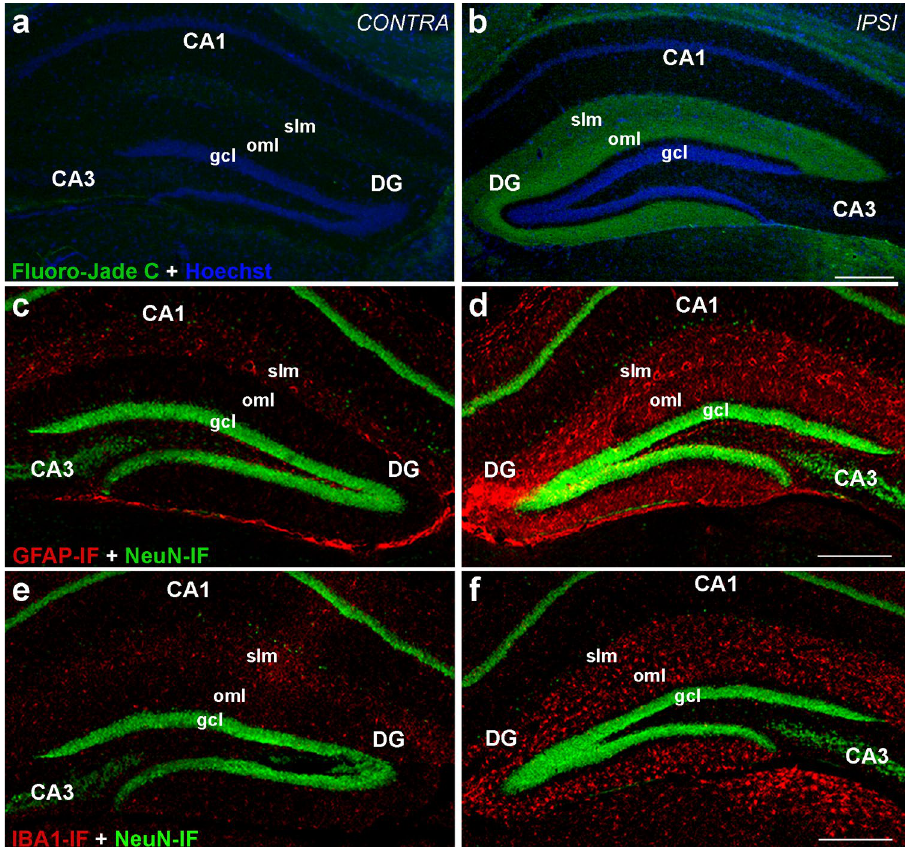
Figure 2. Entorhinal denervation leads to a layer-specific denervation and a layer-specific glial reaction in the outer molecular layer of the dentate gyrus. ( a , b ) Unilateral transection of the perforant path leads to layer- specific denervation in the dentate gyrus (DG) as shown by Fluoro-Jade C staining (green) at 7 days post lesion. The contralateral hippocampus is shown as control ( a ). Note that Fluoro-Jade C staining is seen in the outer molecular layer (oml) of the DG only in the ipsilateral hippocampus ( b ). Nuclei (blue) were counterstained with Hoechst 33342. ( c – f ) Layer-specific activation of glial cells in the DG oml following entorhinal lesion (7 days post lesion). Sections were immunolabeled against glial fibrillary acid protein (GFAP) ( c , d ) and ionized calcium-binding adapter molecule 1 (IBA1) ( e , f ), marker molecules for reactive astrocytes and activated microglia, respectively. The contralateral hippocampus is shown as control (GFAP ( c ); IBA1 ( e )). Strong layer- specific activation of both glial cell types is seen in the denervated oml of the ipsilateral side (GFAP ( d ); IBA1 ( f )). For counterstaining, NeuN (neuronal marker, green) was used. CA1, CA3: cornu ammonis subregions, slm: stratum lacunosum moleculare, gcl: granule cell layer. Scale bars: 250